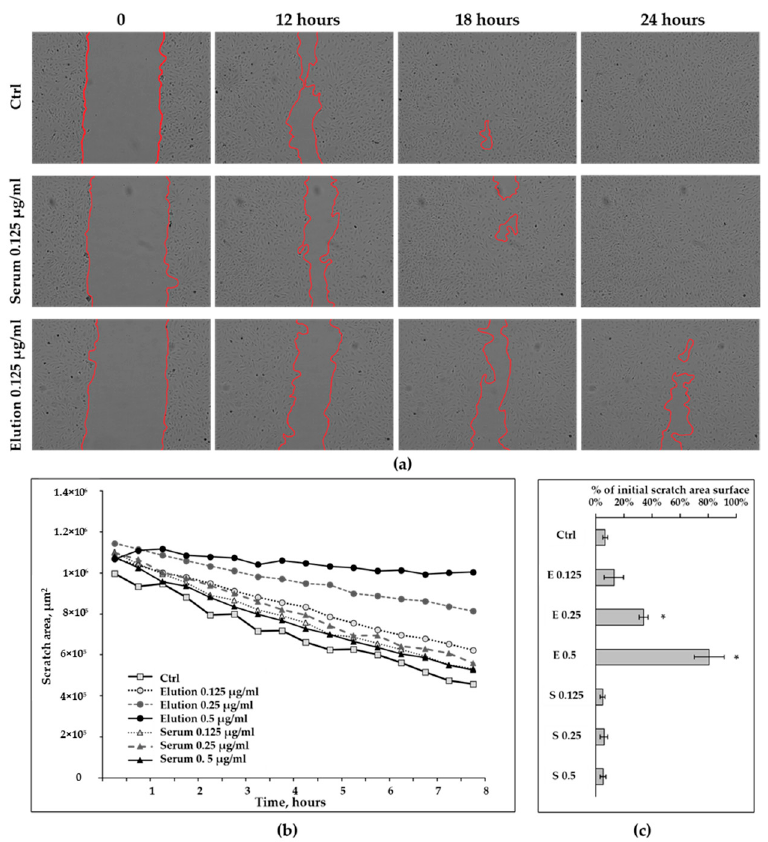
Figure 2. Wound-healing assay in HAECs treated with different concentration of proteins, eluted from the matrix of the hemoadsorber (E) and corresponding concentrations of human serum (S) (n = 3). ( a ) Representative microphotographs of the HAECs at different time points after scratch. Scratch borders are delineated in red; all microphotographs are taken with 4×magnification. ( b ) Dynamics of scratch area changes during the 8 h. ( c ) Percentage of initial scratch area surface after 24 h. Data are presented as mean ± SEM, * p < 0.05 ( t -test) compared to the untreated control.